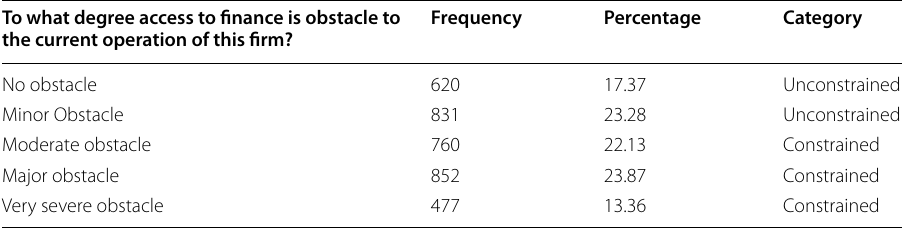
Table 8 Access to finance as obstacle to doing business